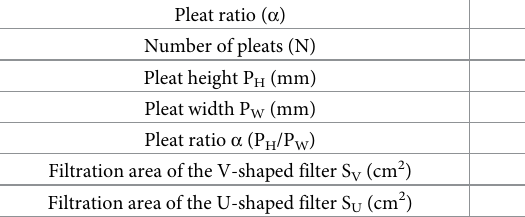
(8543, TSI, the USA) and a HWA (VelociCalc air velocity meter Model 9565, TSI, the USA), which were used to measure the pressure drop of the filter, the dust concentration and local air velocity, respectively. For the AP800, the maximum range was 15 inH O; the resolution was 2 0.001 inH O; and the error was less than 1%. The DustTrak environmental monitor 8543 was 2 employed to monitor the PM , PM and total dust concentrations. For the air velocity meter 1.0 2.5 Model 9565, the range was 0–50 m/s; the resolution was 0.01 m/s; and the error was less than 3%.